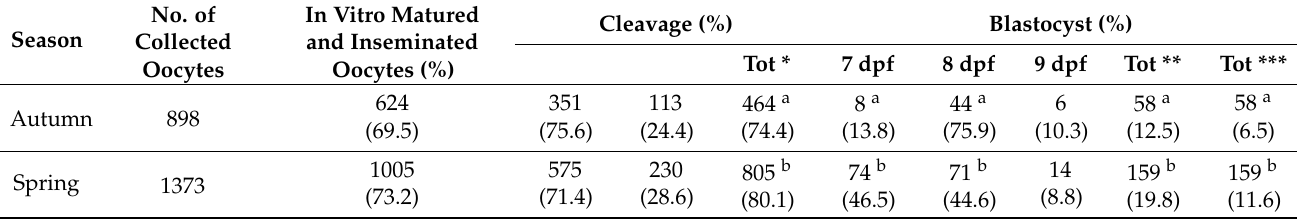
Table 1. Developmental competence of prepubertal ovine oocytes collected during spring and